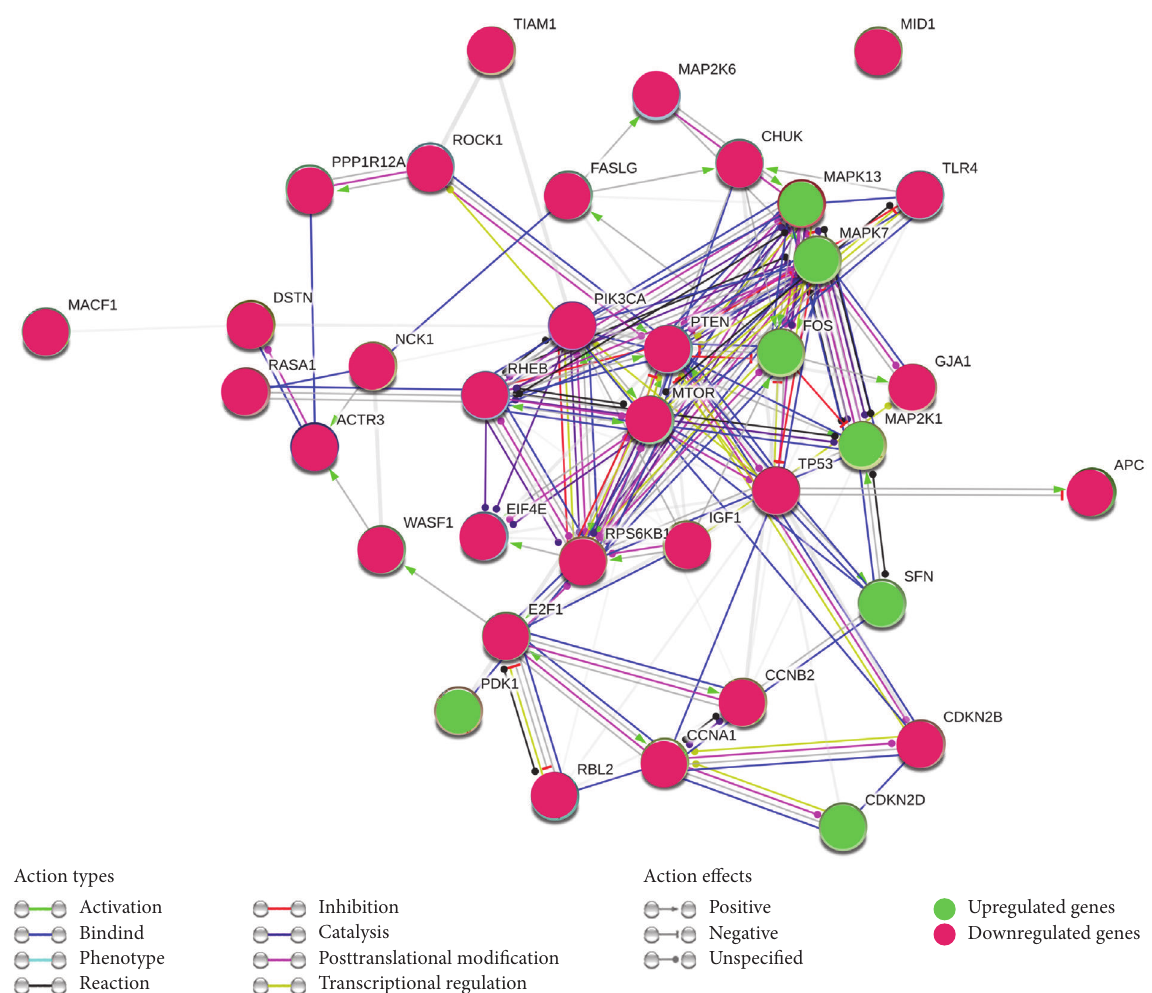
Figure 8: Interactive network of migration-related genes altered under short-term hypoxic stress. The database STRING 9.1 was used to find and visualise predicted protein-protein